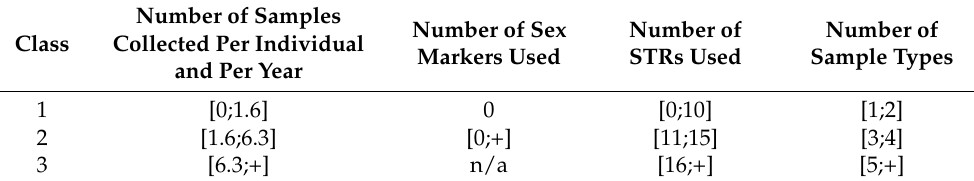
Table 1. Methodological variables used in the MCA and their